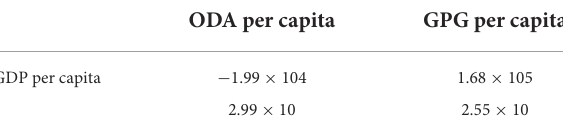
TABLE 7 Crowding-out effect of GPGs and the dependent variable. ODA per